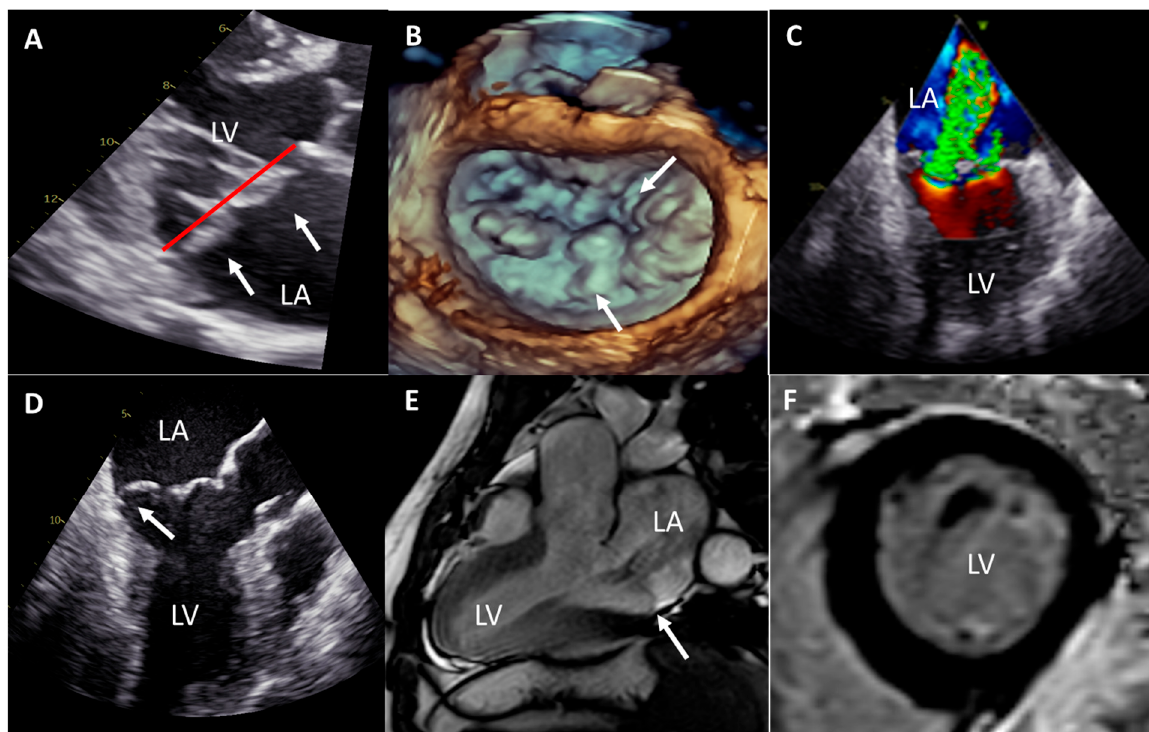
Figure 2. Imaging of the mitral valve prolapse and of the left ventricle. ( A )Trans-thoracic echocardiography, parasternal long-axis view, demonstrating thickened bi-leaflet prolapse (white arrows) of the mitral valve. The red line identifies the mitral annular level. LA: left atrium; LV: left ventricle. ( B ) Trans-esophageal 3D echocardiography of the mitral valve, showing the detailed anatomy of the multi-scallop, bi-leaflet prolapse (white arrows) of the Barlow ′ s-like mitral valve. ( C ) Trans-esophageal Color Doppler echocardiography (bi-commissural view), showing the severe (multi-jet) mitral regurgitation. ( D ) Trans-esophageal echocardiography (three-chamber view) showing the prolapse of the mitral valve posterior leaflet and mitral annular disjunction (MAD) (white arrow). ( E ) CMR (three-chamber view cine) showing the prolapse of the mitral valve with mild MAD and dilated LV. CMR: cardiac magnetic resonance. ( F ) CMR (delayed enhancement scan of one representative slice of the short axis at the level of the papillary muscles), showing no evidence of macroscopic myocardial fibrosis/scar (black myocardium without any white signal).